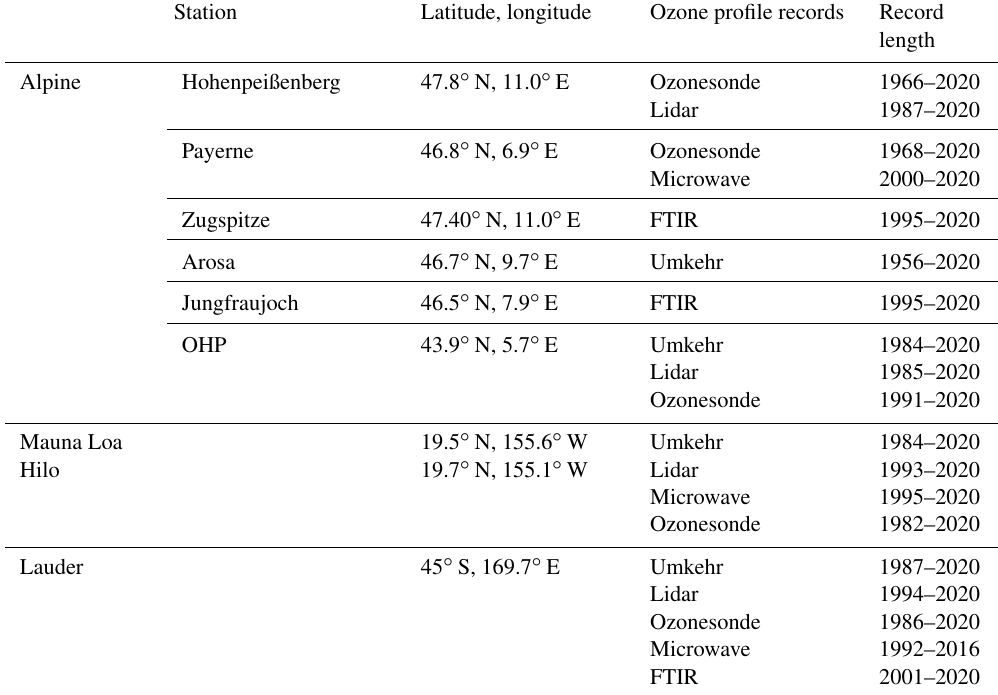
Station Latitude, longitude Ozone profile records Record